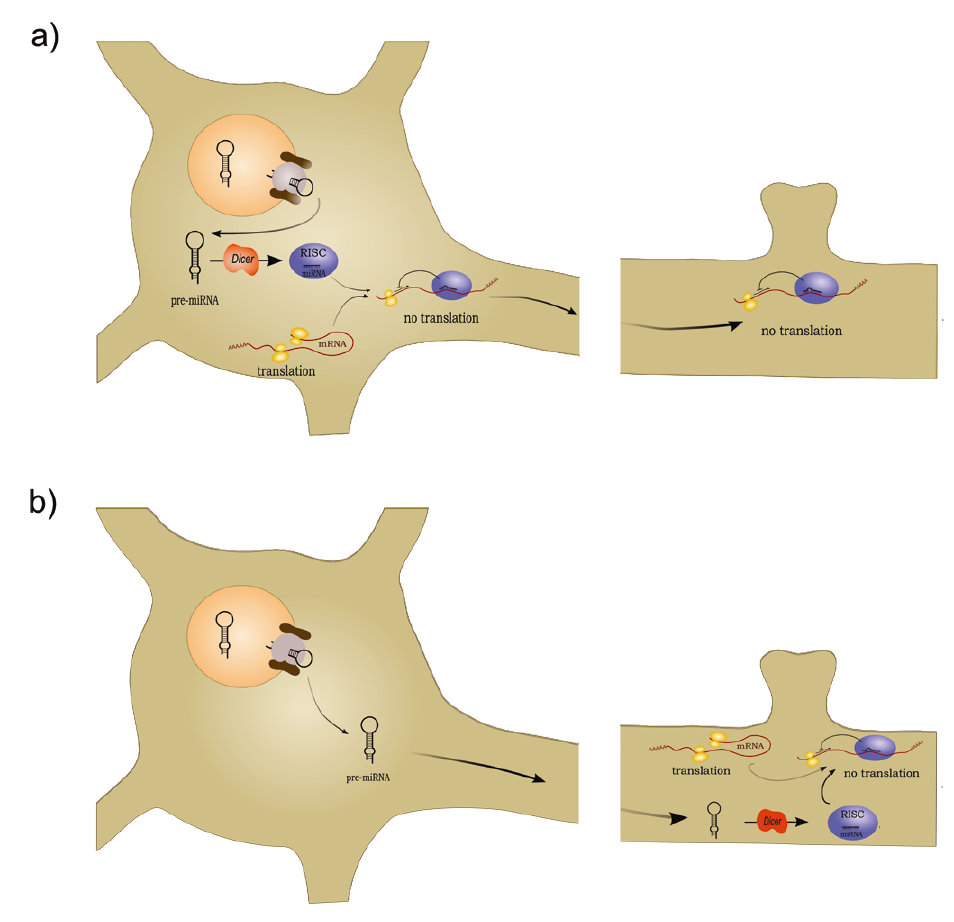
FIGURE 3. Possible mechanisms for dendritic transport of microRNAs. (a) “Hitchhiking mode”: mature microRNA bind to the target mRNA in the neuronal cell soma, and the microRNA/mRNA complex is actively transported into the dendrites. (b) “Zip code model”: dendritic microRNA precursor contains targeting element (“zip code”). This element is recognized by transport proteins that deliver the precursor into the dendrites. For details see